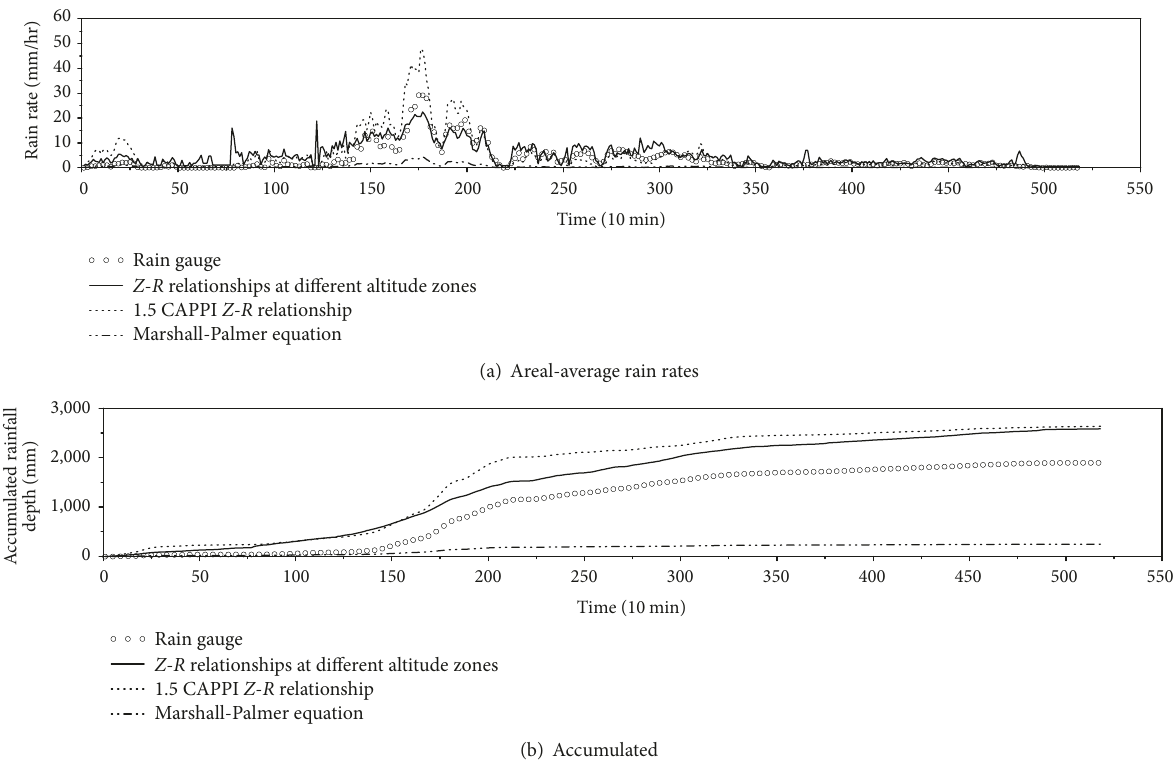
Island during Typhoon Nakri. The resulting 𝑍 - 𝑅 relationship is 𝑍 = 4.44𝑅 1.6